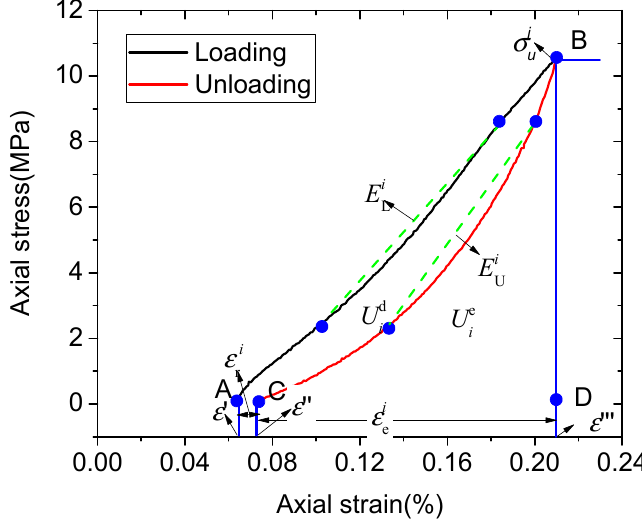
Figure 9. Diagram of elastic deformation, residual deformation, elastic modulus elastic energy, and dissipated energy under cyclic loading-unloading condition.